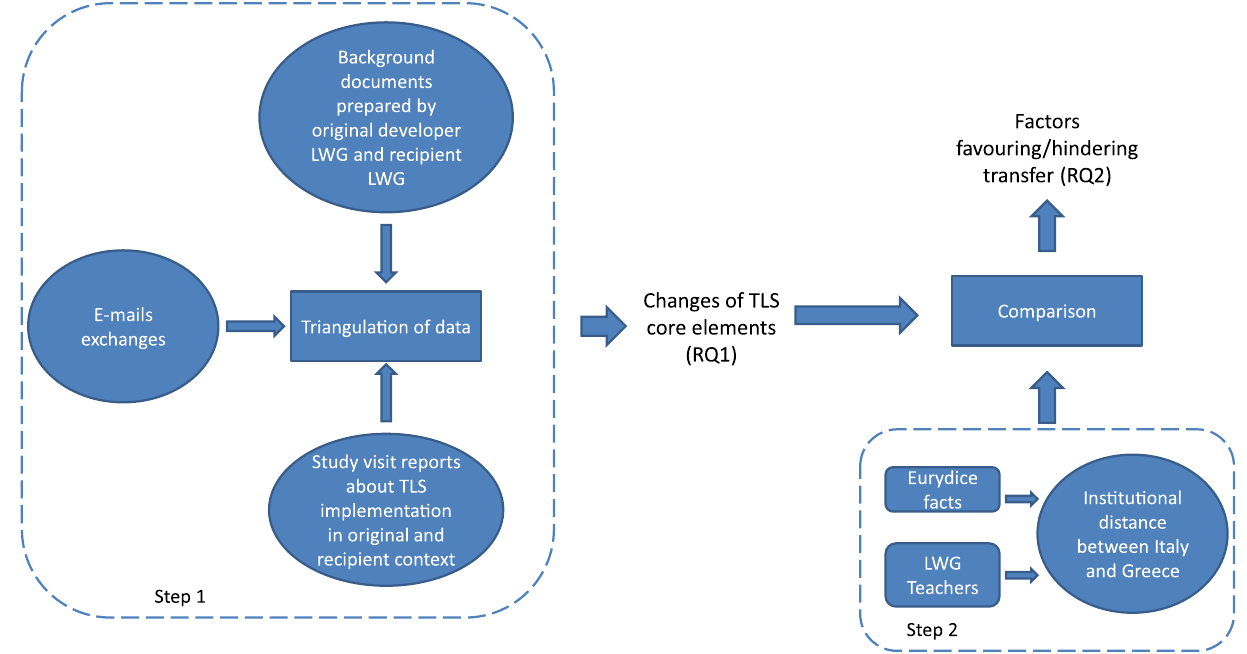
FIG. 3. Schema of data